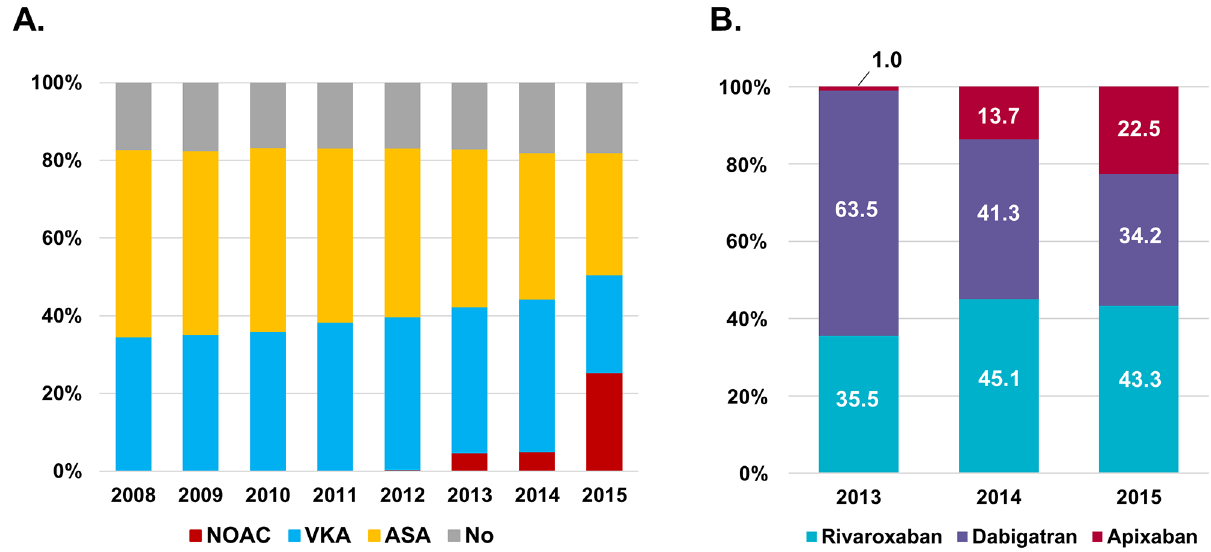
Fig 1. Temporal trends of antithrombotic therapy prescription. A. Temporal trends of antithrombotic therapy prescription in patients with CHA 2 DS 2 -VASc score (cid:21) 2. B. Distributionof three NOACs use since 2013 in patients with CHA 2 DS 2 -VASc score (cid:21) 2. Abbreviation: ASA, aspirin; NOAC, non-vitamin K oral anticoagulants; VKA, vitamin K antagonists.